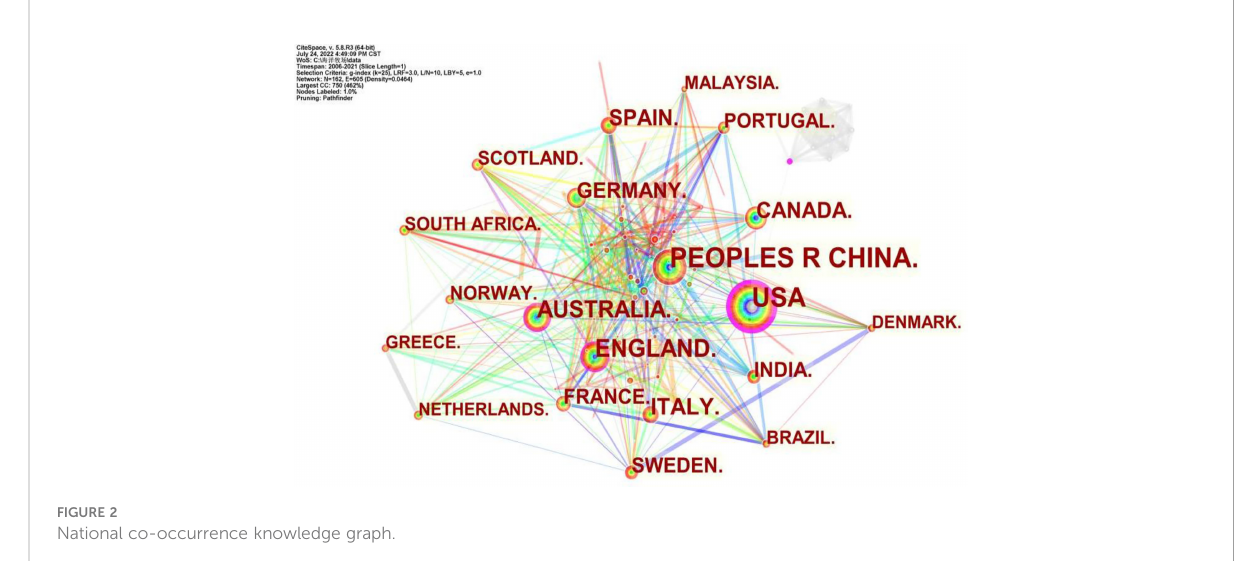
FIGURE 2 National co-occurrence knowledge graph.